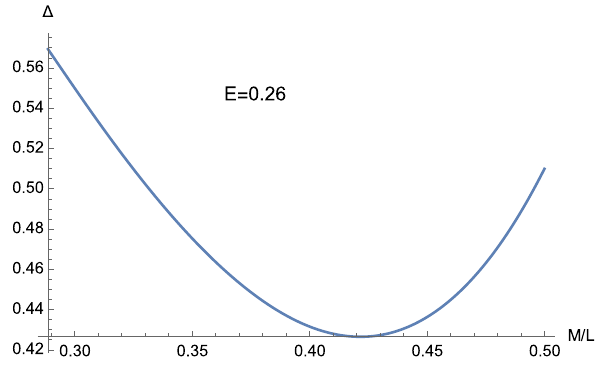
Fig. 3 The discriminant (3.4) obtained with E = 0 . 26 and C = 1. It